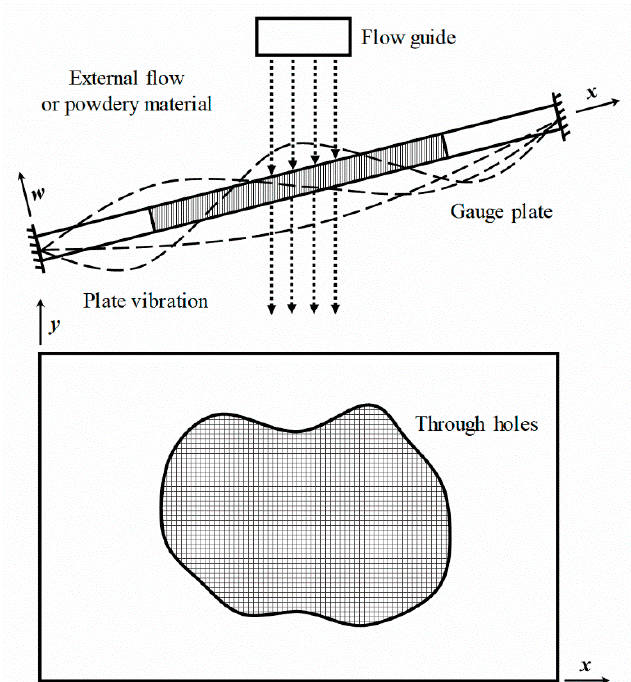
Figure 1. Principle of the flowmeter for measuring the mass flow rate by sensing the vibration characteristics excited by the external flow.